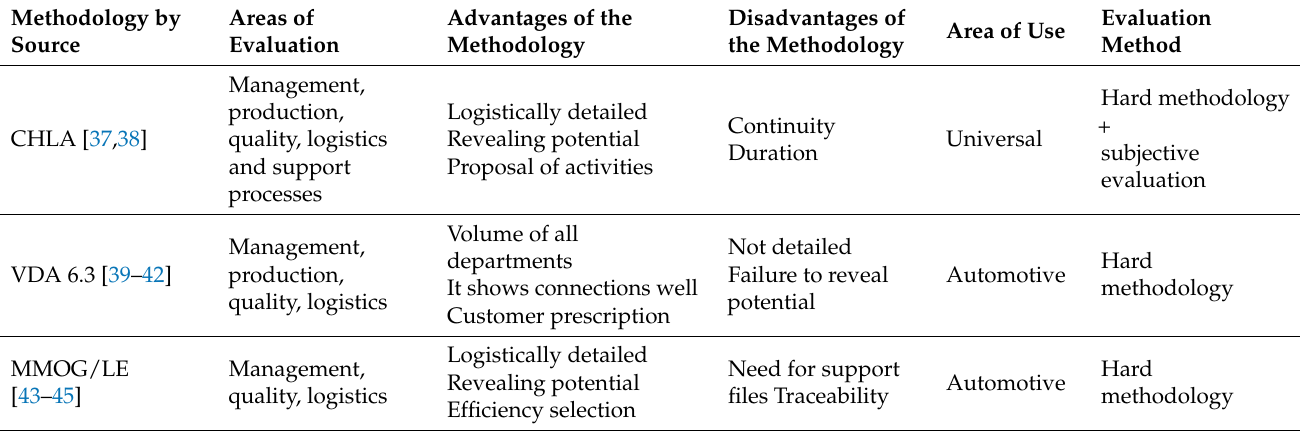
Table 1. Analysed attributes of the logistics audit